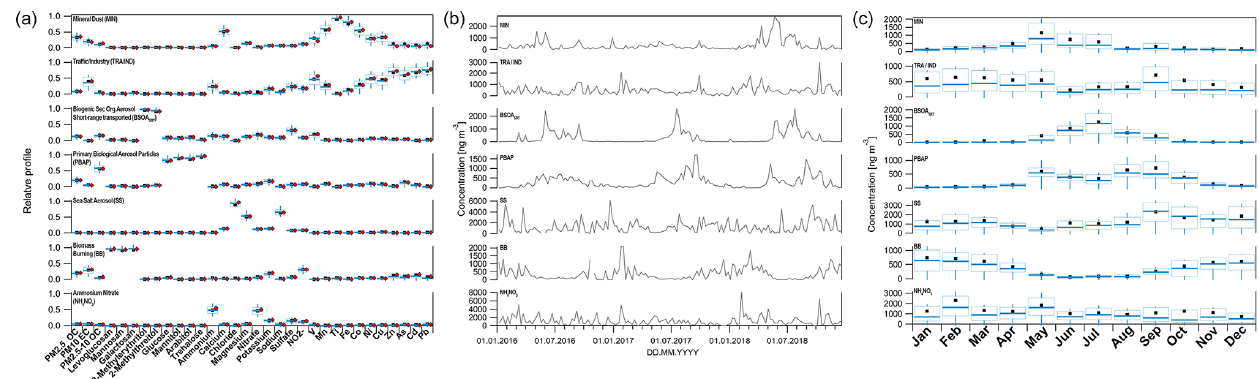
Figure 2. Results from PMF for Birkenes for 2016–2018, showing the (a) factor profiles, (b) factor time series, and (c) aggregated monthly data. The box plots in panels (a) and (c) show statistics from bootstrapped solutions ( n = 5000), including the 25th and 75th percentiles (boxes), the median (horizontal lines), and the 10th and 90th percentiles (whiskers). Black markers are the means. The red markers in panel (a) show the base factor profiles. Table 1. Variables describing the biomass burning source derived from the PMF BB factor in the present study, and the comparable variables obtained by 14 C analysis reported by Zotter et al.